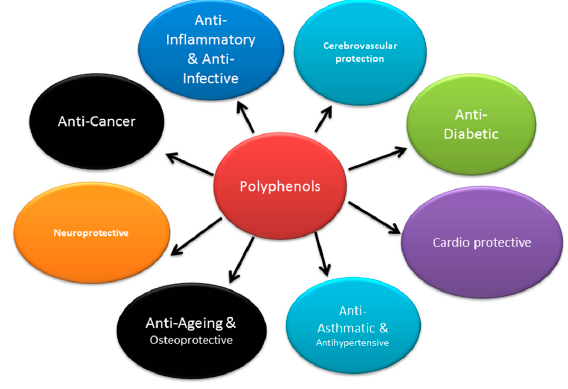
Figure 1. Role of polyphenols in humans.